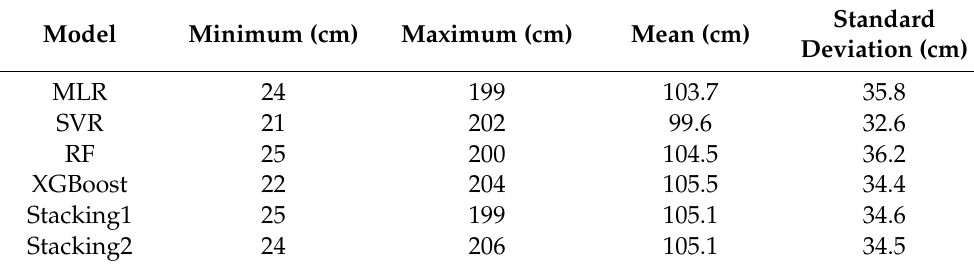
Figure 9. Soil thickness maps obtained from different models. Table 4. Descriptive statistics of soil thickness predicted from different models.